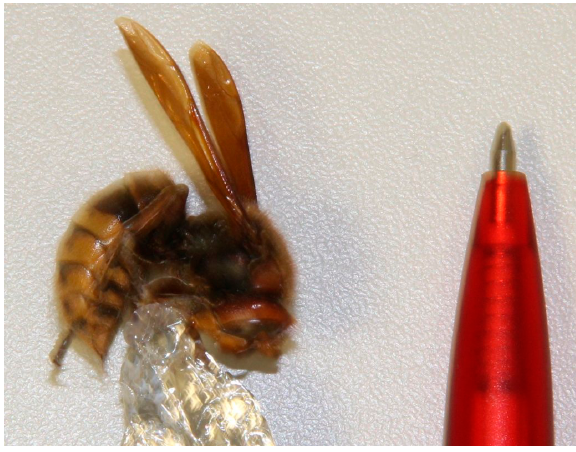
Figure 6. A dried hornet.